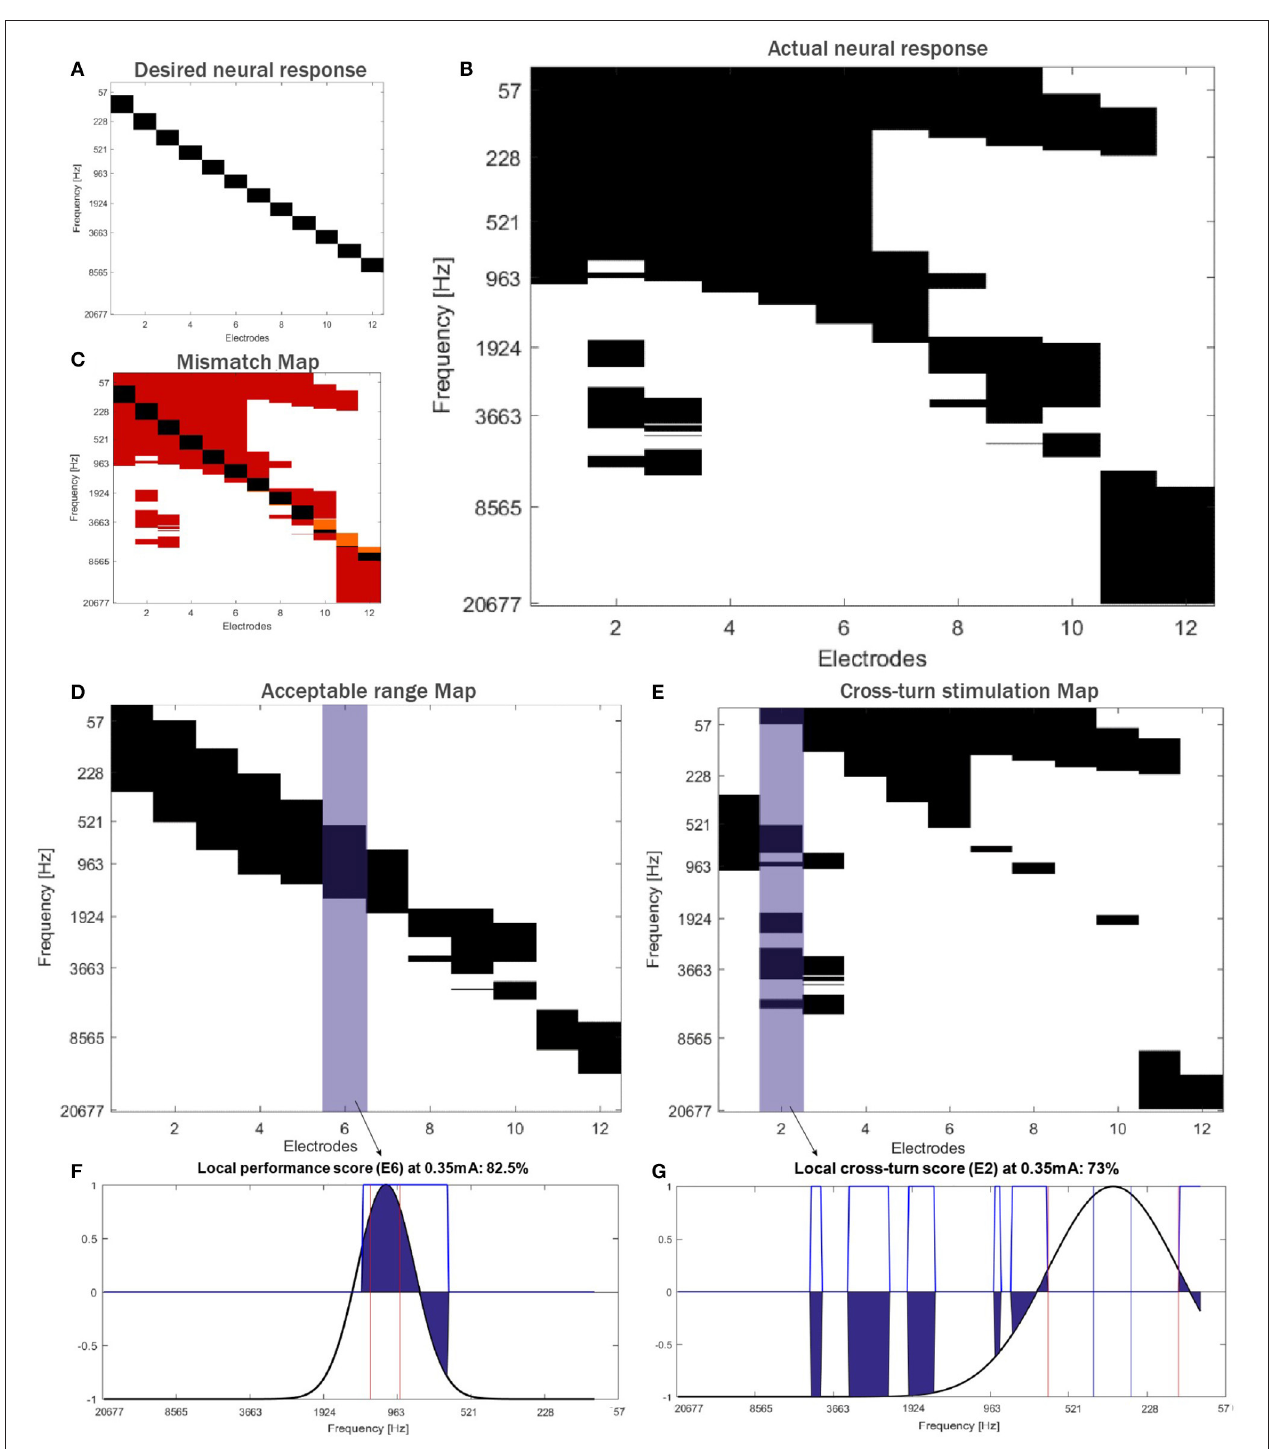
FIGURE 4 | Activation maps for (A) the desired and (B) the actual neural response, and (C) mismatch map computed in a randomly generated virtual patient. Each electrode on the array is numbered, from the tip (E1) to the base of the array (E12). The actual activation map is split and evaluated according to the stimulation found in the half turn of the cochlea where the mid target frequency is located at the middle of the cochlea section evaluated (D) . The activation at the rest of the cochlea (E) is considered as cross-turn stimulation. Local performance score for E6 (F) and local cross-turn score for E2 (G) . Activation profiles of both electrodes are highlighted in blue in their corresponding